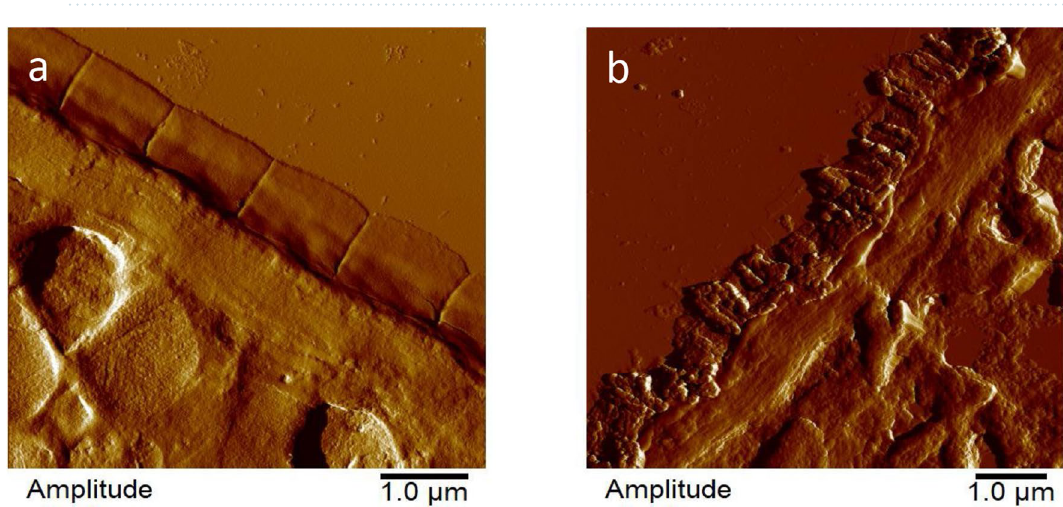
Figure 3. Representative AFM images of 350 nm thick ultramicrotomic sections of young adult C. elegans after 24 h of treatment. ( a ) Untreated control (M9 buffer with 1% DMSO). ( b ) Worms treated with CM (2